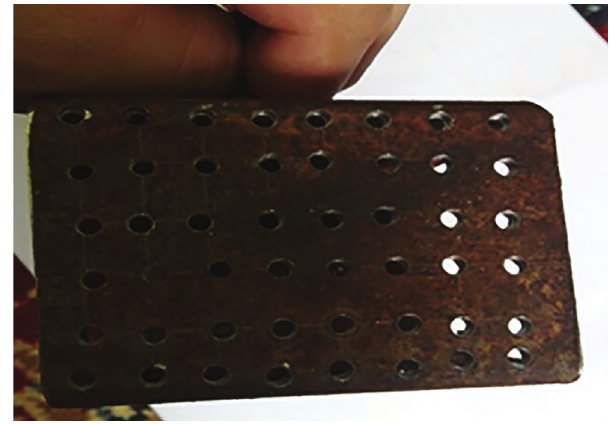
Figure 7 - Side view of a device for bone allograft channeling. The holes with a diameter of 3.2 mm for perforation are visible on the side wall